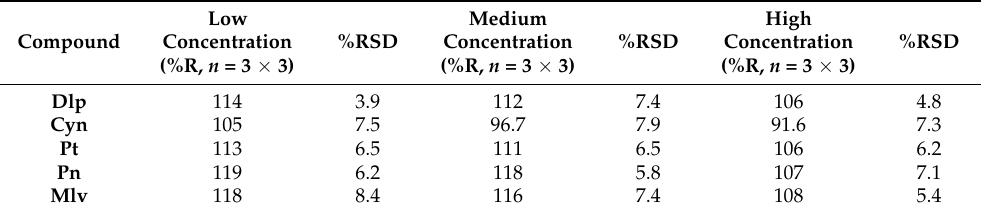
Table 4. Repeatability results of the method estimated as recoveries (%R, n = 6) for the studied anthocyanins at three fortification